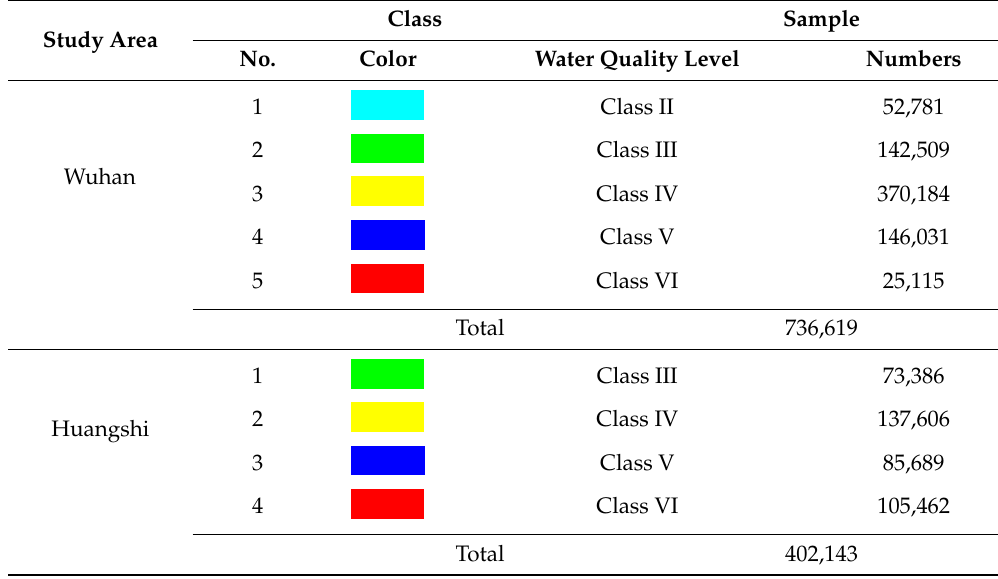
Table 4. Water quality levels and numbers of samples in the Wuhan and Huangshi datasets.